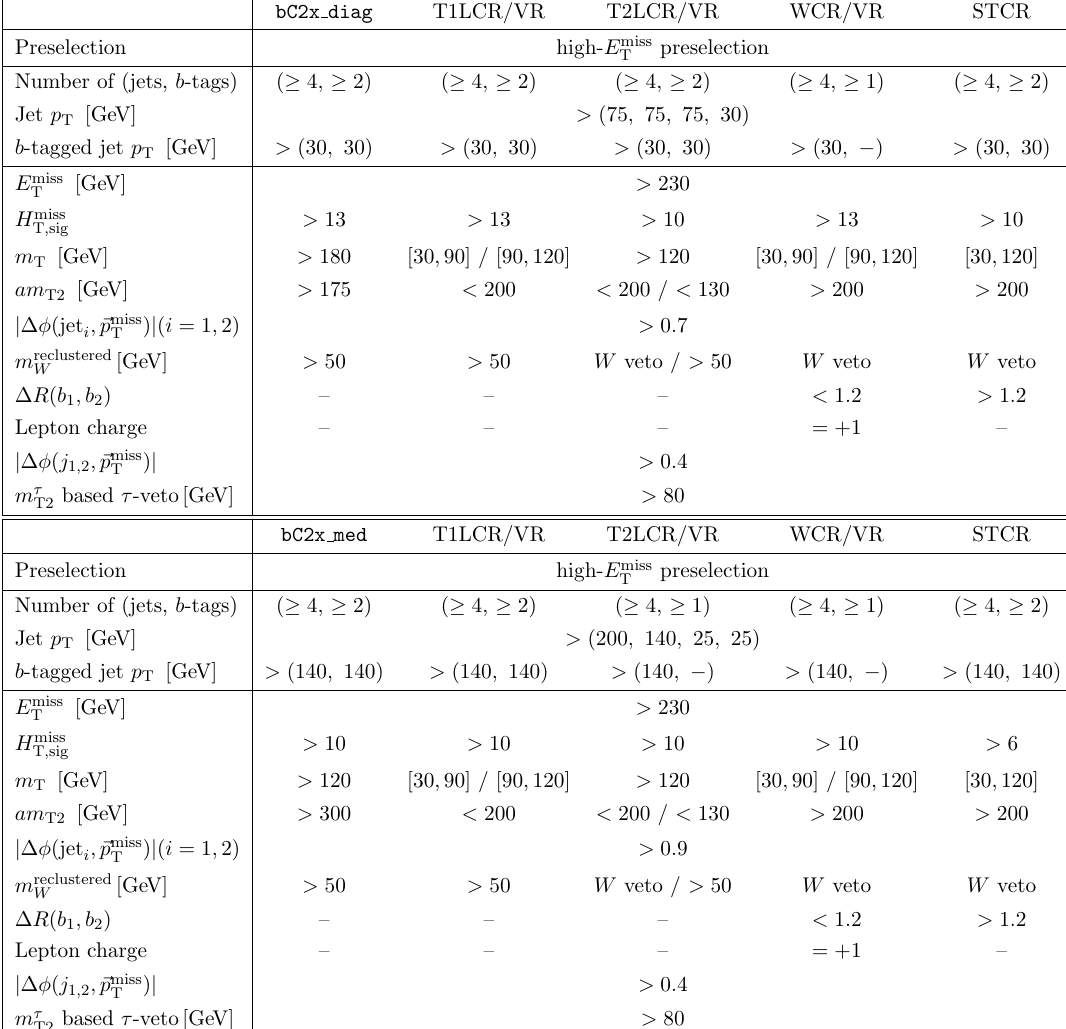
Table 18 . Overview of the selections for the bC2x diag and bC2x med signal regions as well as the associated control and validation regions. The control regions include the semileptonic t (cid:22) t control region (T1LCR), the dileptonic t (cid:22) t control region (T2LCR), the W +jets control region (WCR), and the single-top Wt control region (STCR). The validation regions include the semileptonic t (cid:22) t validation region (T1LVR), the dileptonic t (cid:22) t validation region (T2LVR), and the W +jets validation region (WVR). List values are provided in between parentheses and square brackets denote